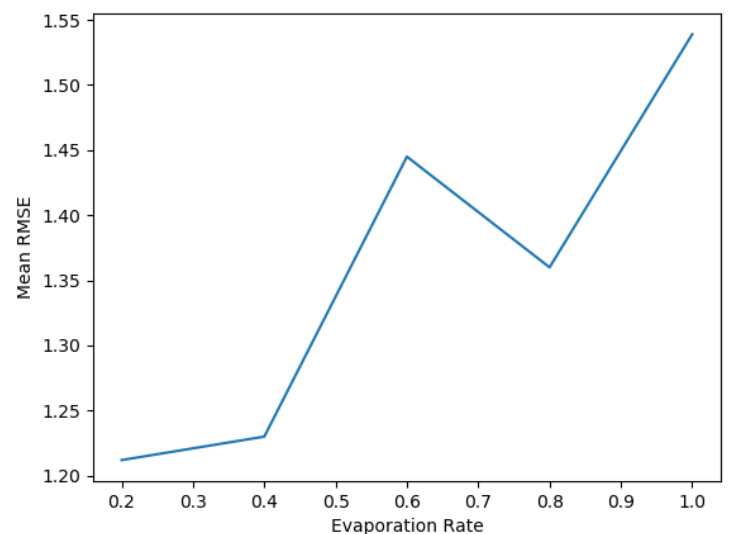
Figure 1. Empirical evaluation of Root Mean Square Error (RMSE) over different value of evaporation rate λ